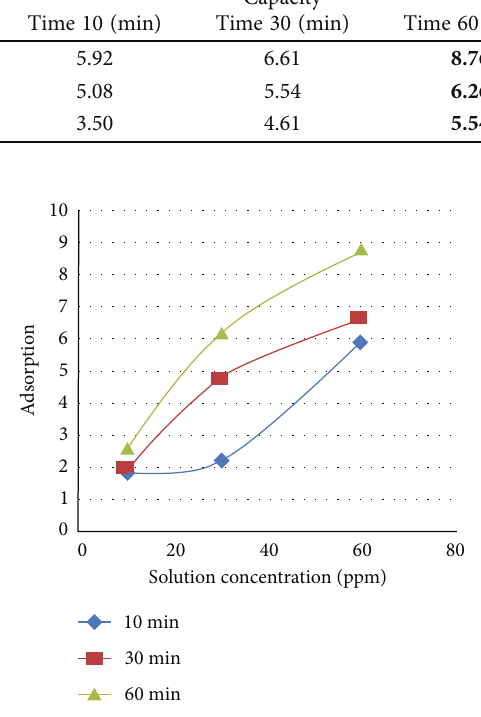
Figure 4: The relationship of concentrations of solutions with adsorption for di ff erent times at the pH 2.